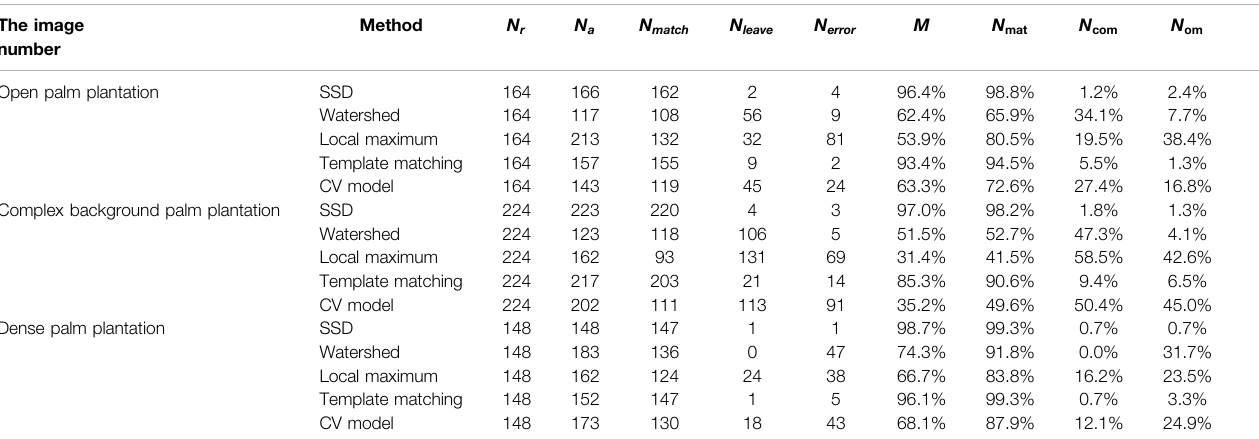
TABLE 5 | Single tree inspection accuracy evaluation. The image